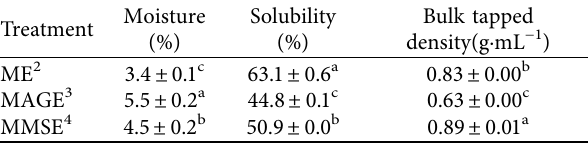
Table 4: Physical properties of Moringa peregrina microcapsules 1